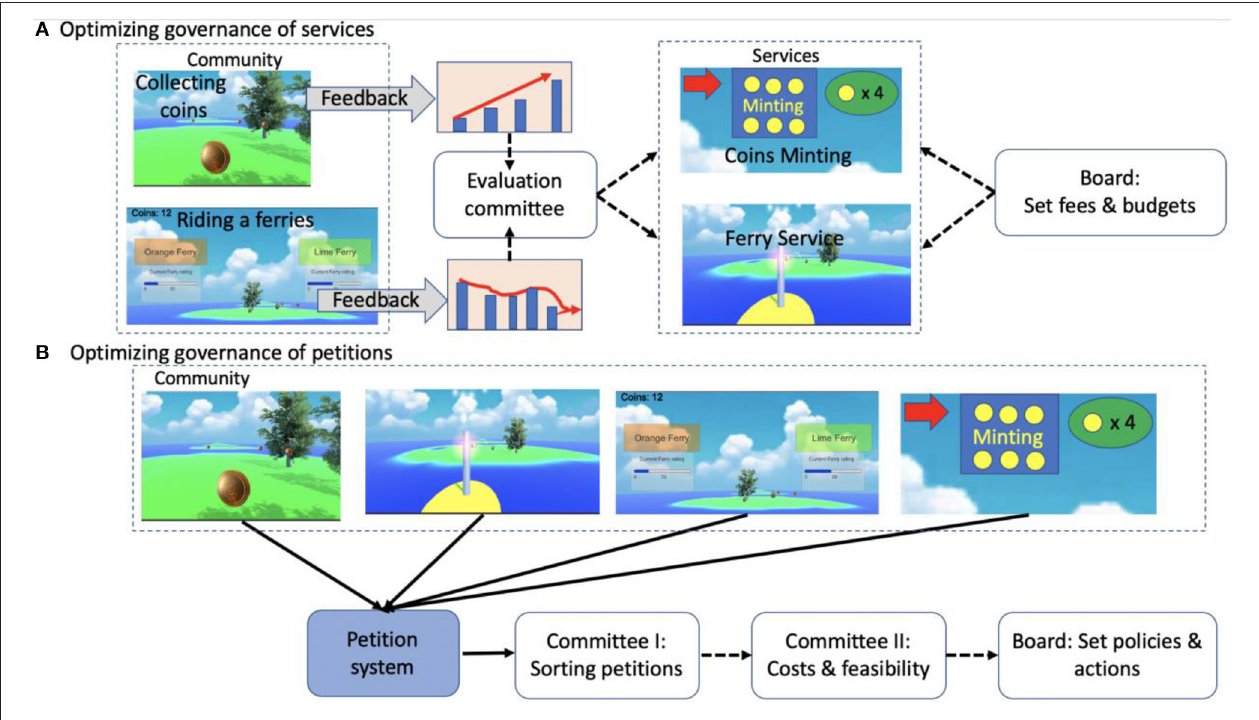
FIGURE 5 | Ferry Services Game experiment with governance. (A) FSG design simulating governance of pooled resources (services) via feedback in a community (no- market, as in Figure 1A ). Groups of participants work in providing simulated services (e.g., driving ferries or minting coins) and another group represents community members who use these services (riding ferries and collecting coins). Feedback from participants’ satisfaction and service usage is aggregated into dashboard presenting trends. These trends then feed into governance logic. (B) FSG design simulating a petition governance (as in Figure 1B